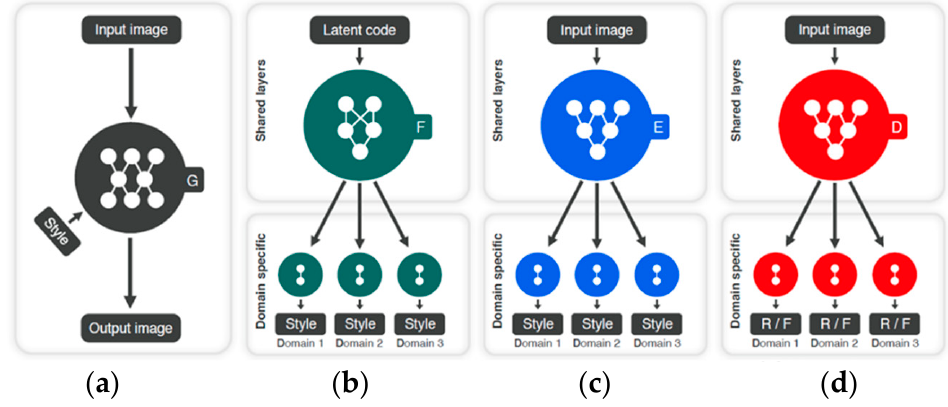
Figure 17. StarGAN architecture; ( a ) generator, ( b ) mapping network, ( c ) style encoder, and ( d ) discriminator [38].